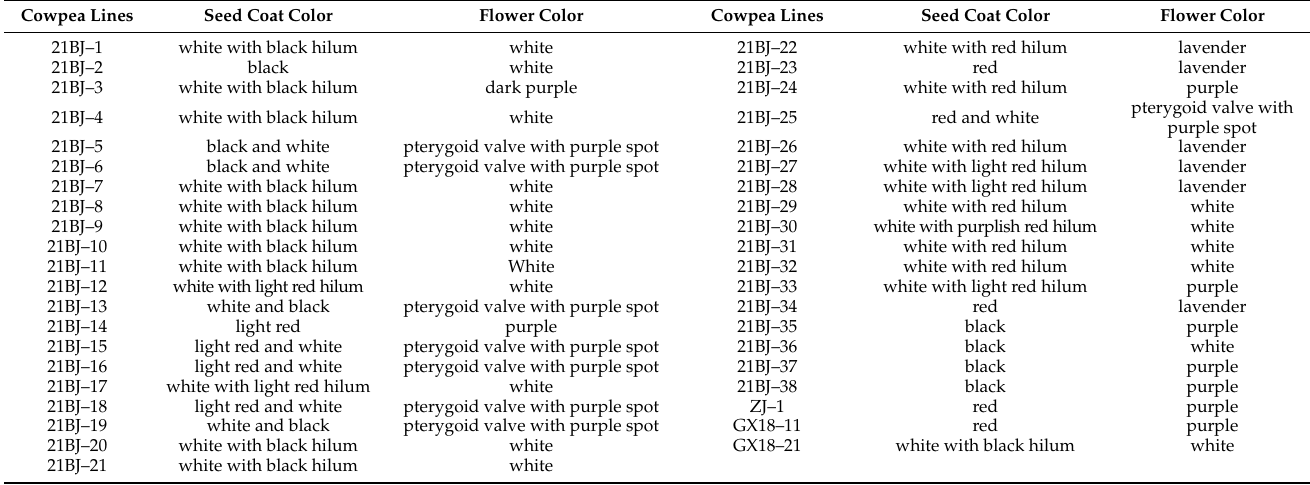
Table 1. Characteristics of 41 cowpea